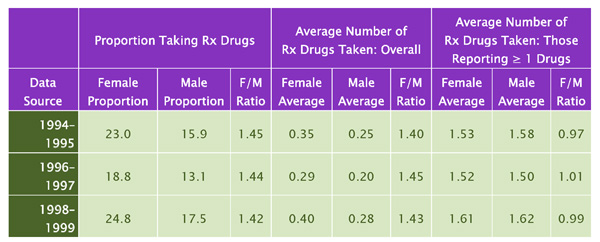
Proportion of Canadians 20+ Years Using any Prescription (Rx) Medication and Average Number of Different Drugs Used Source: Statistics Canada, NPHS, various years